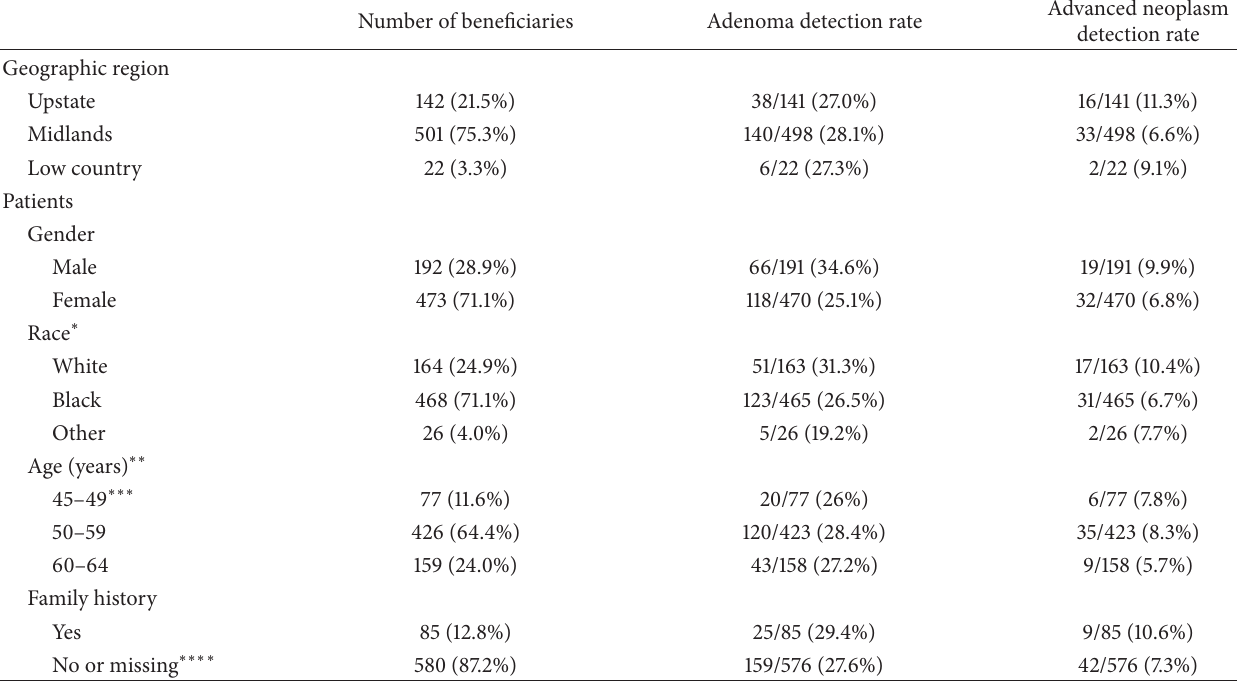
Table 2: SCOPE SC beneficiary demographics and corresponding adenoma detection rates ( 𝑛 = 665